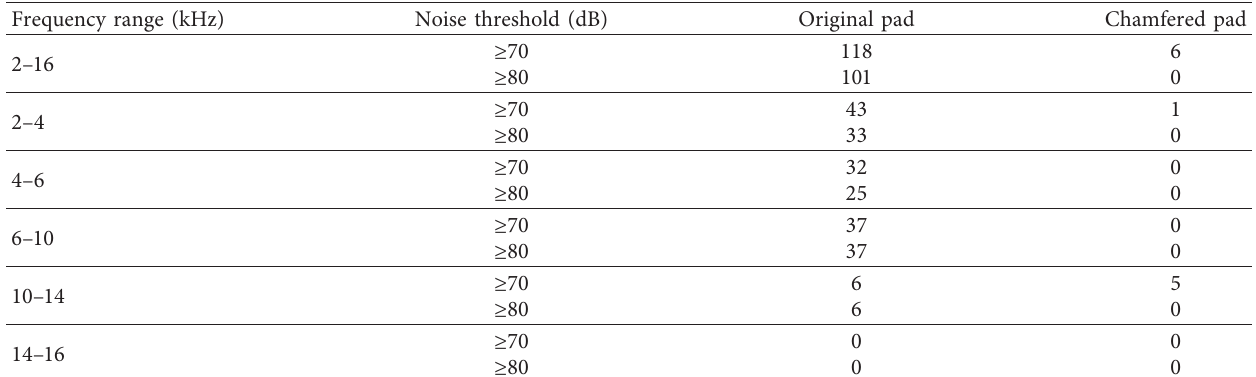
Table 6: Noise characteristics of brake pads before and after